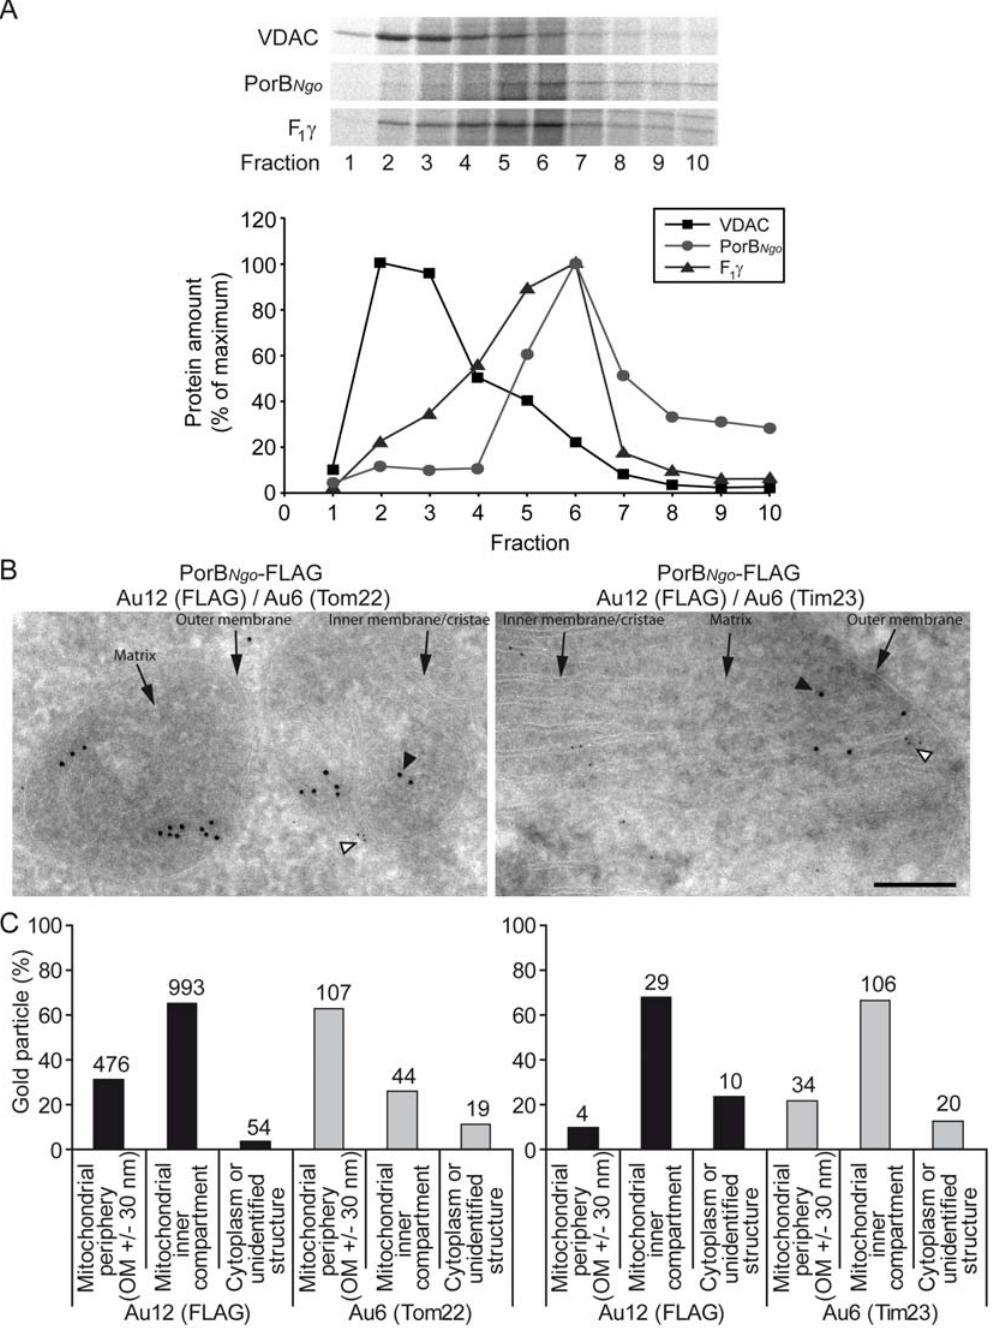
Figure 4. Association of PorB with the mitochondrial inner membrane. ( A ) Sucrose density gradient. 35 S-labelled PorB, together with the marker proteins VDAC (outer membrane) and F1 c (the ATP-synthase c -subunit, inner membrane), were synthesized in reticulocyte lysate and imported into isolated yeast mitochondria. Following treatment with proteinase K, membrane vesicles were prepared by sonication and separated on a linear sucrose gradient (0.85–1.6 M sucrose). The fractions were analyzed by SDS-PAGE and a phosphorimager. The highest value for each protein was set at 100% (control). ( B ) Localization of PorB at the IMM in HeLa cells. HeLa cells were transfected with an expression construct of FLAG-tagged PorB. PorB was detected in porB -transfected cells by immunogold labelling using an antibody directed against the FLAG-tag and a secondary antibody linked to 12 nm gold particles. Endogenous proteins of the OMM (Tom22) and IMM (Tim23) were co-stained with the respective antisera and a secondary antibody linked to 6 nm gold particles. Arrows represent different features of mitochondria (outer membrane, inner membrane and matrix). Arrowheads show 12 nm (closed arrowheads) or 6 nm (open arrowheads) gold particles on electronmicrographies. ( C ) Quantification of (B). Gold particles were counted to determine the intramitochondrial localization of PorB, Tom22 and Tim23. The actual number of counted gold particles is indicated above the individual bars.